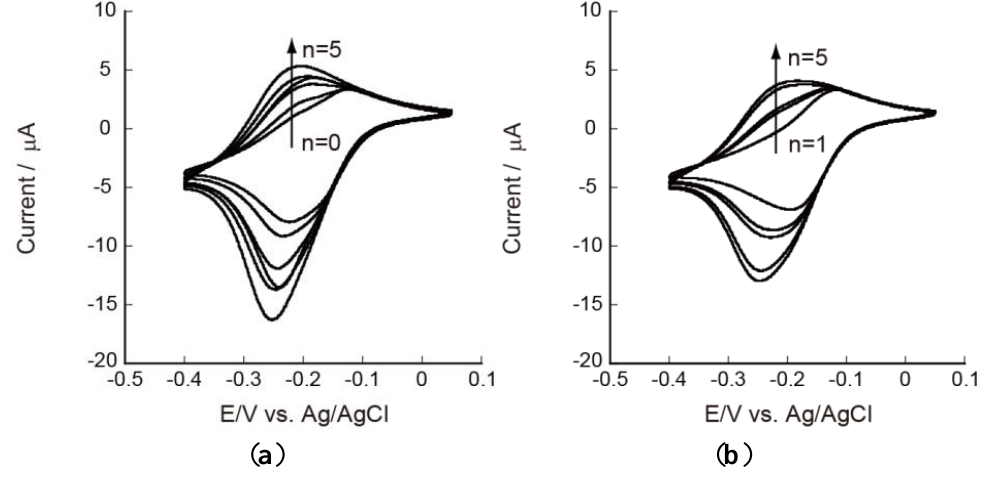
Figure 7. CVs of 5 mM Ru(NH films at pH